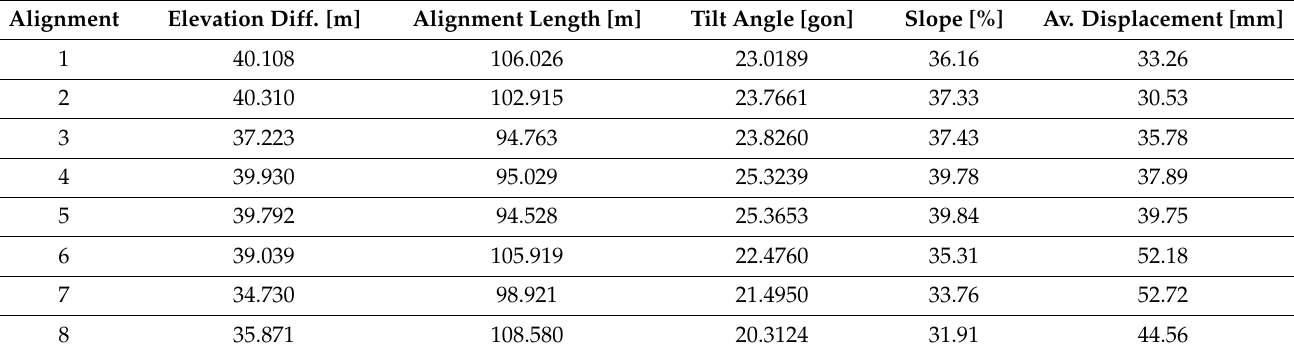
Table 2. Alignment